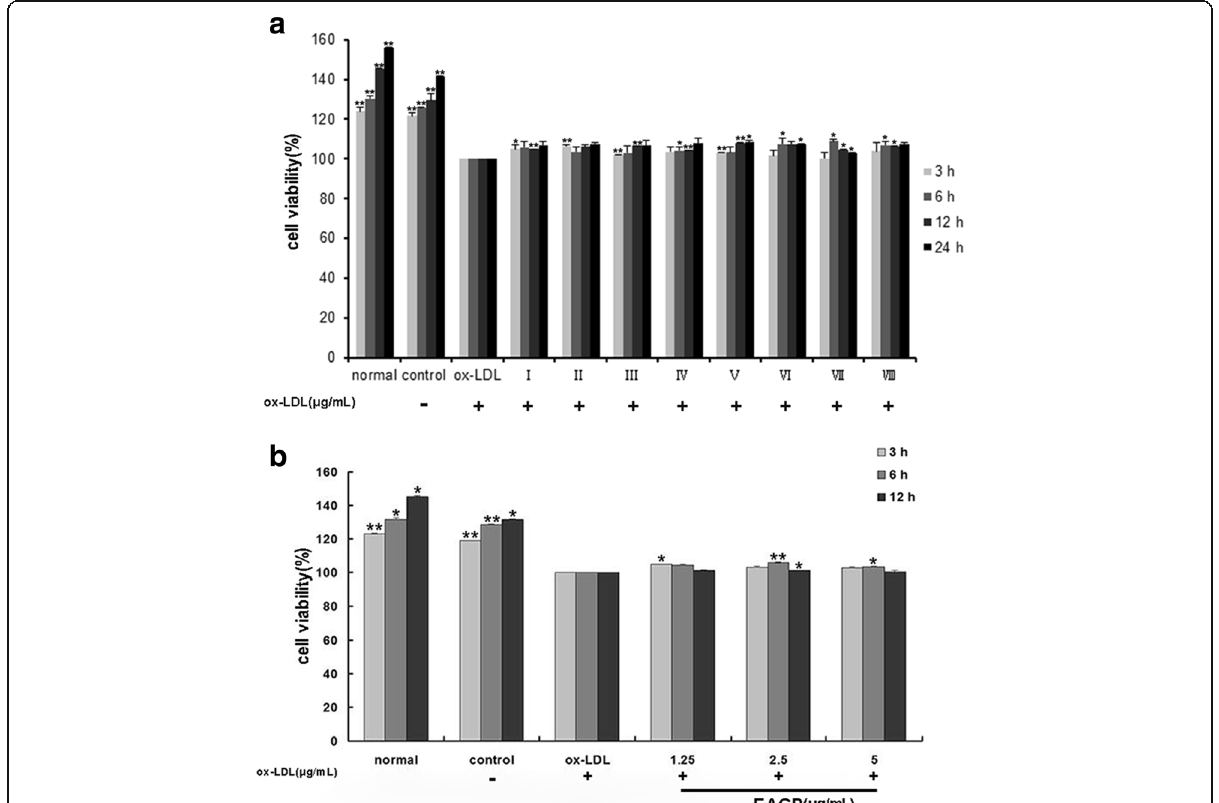
Fig. 1 Effects of 8 subfractions separated from ethyl acetate extract of Chinese propolis (EACP) and EACP on cell viability in ox-LDL induced HUVECs injury. a , Effects of the 8 subfractions separated from EACP (2.5 μ g/mL) on cell viability in ox-LDL (40 μ g/mL) induced HUVECs for 3, 6, 12 and 24 h. b , Effects of the EACP (1.25, 2.5 and 5 μ g/mL) on cell viability in ox-LDL induced HUVECs at 3, 6 and 12 h. Cell viability was tested by